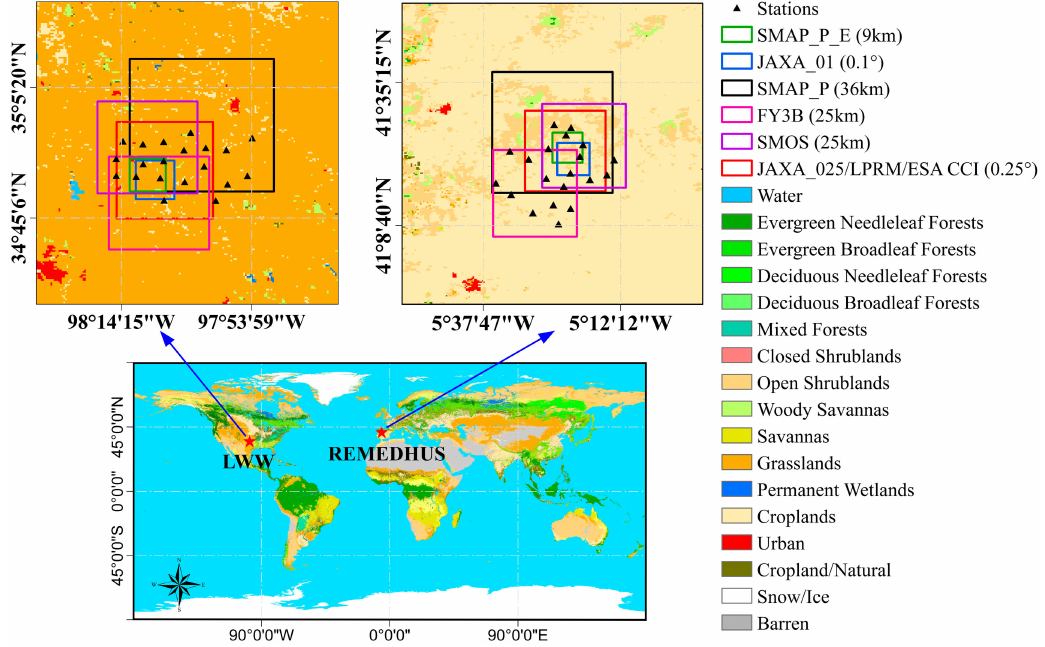
Figure 1. Location of the Little Washita Watershed (LWW) and REMEDHUS networks, the distribution of the corresponding stations, and the satellite pixel locations in each network. The legend of the color map denotes the Moderate Resolution Imaging Spectroradiometer (MODIS) International Geosphere Biosphere Program (IGBP) global land cover